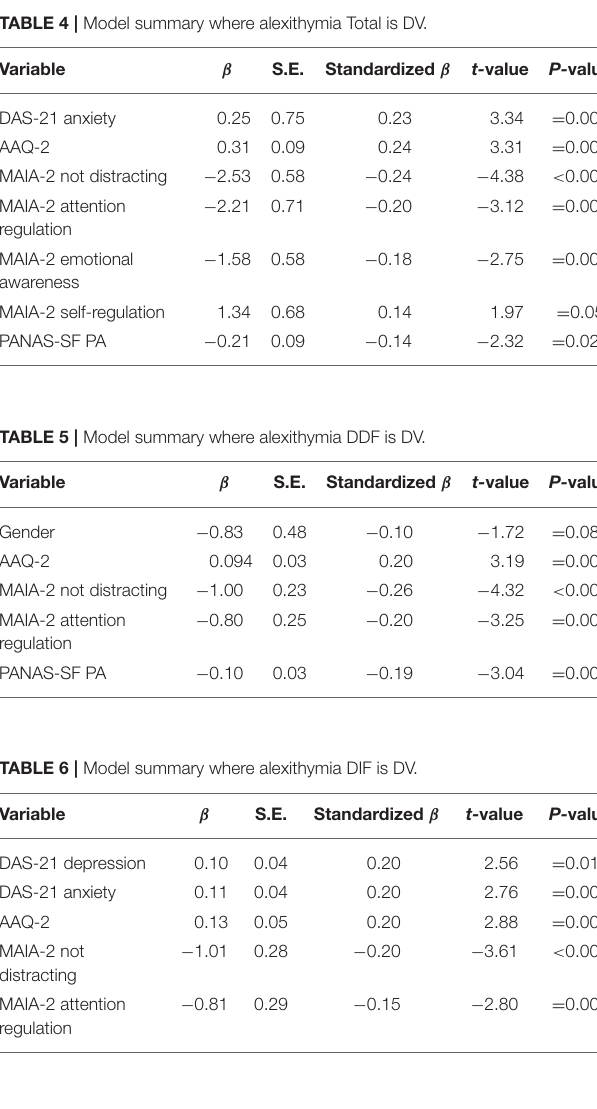
TABLE 7 | Model summary where alexithymia EOT is DV.